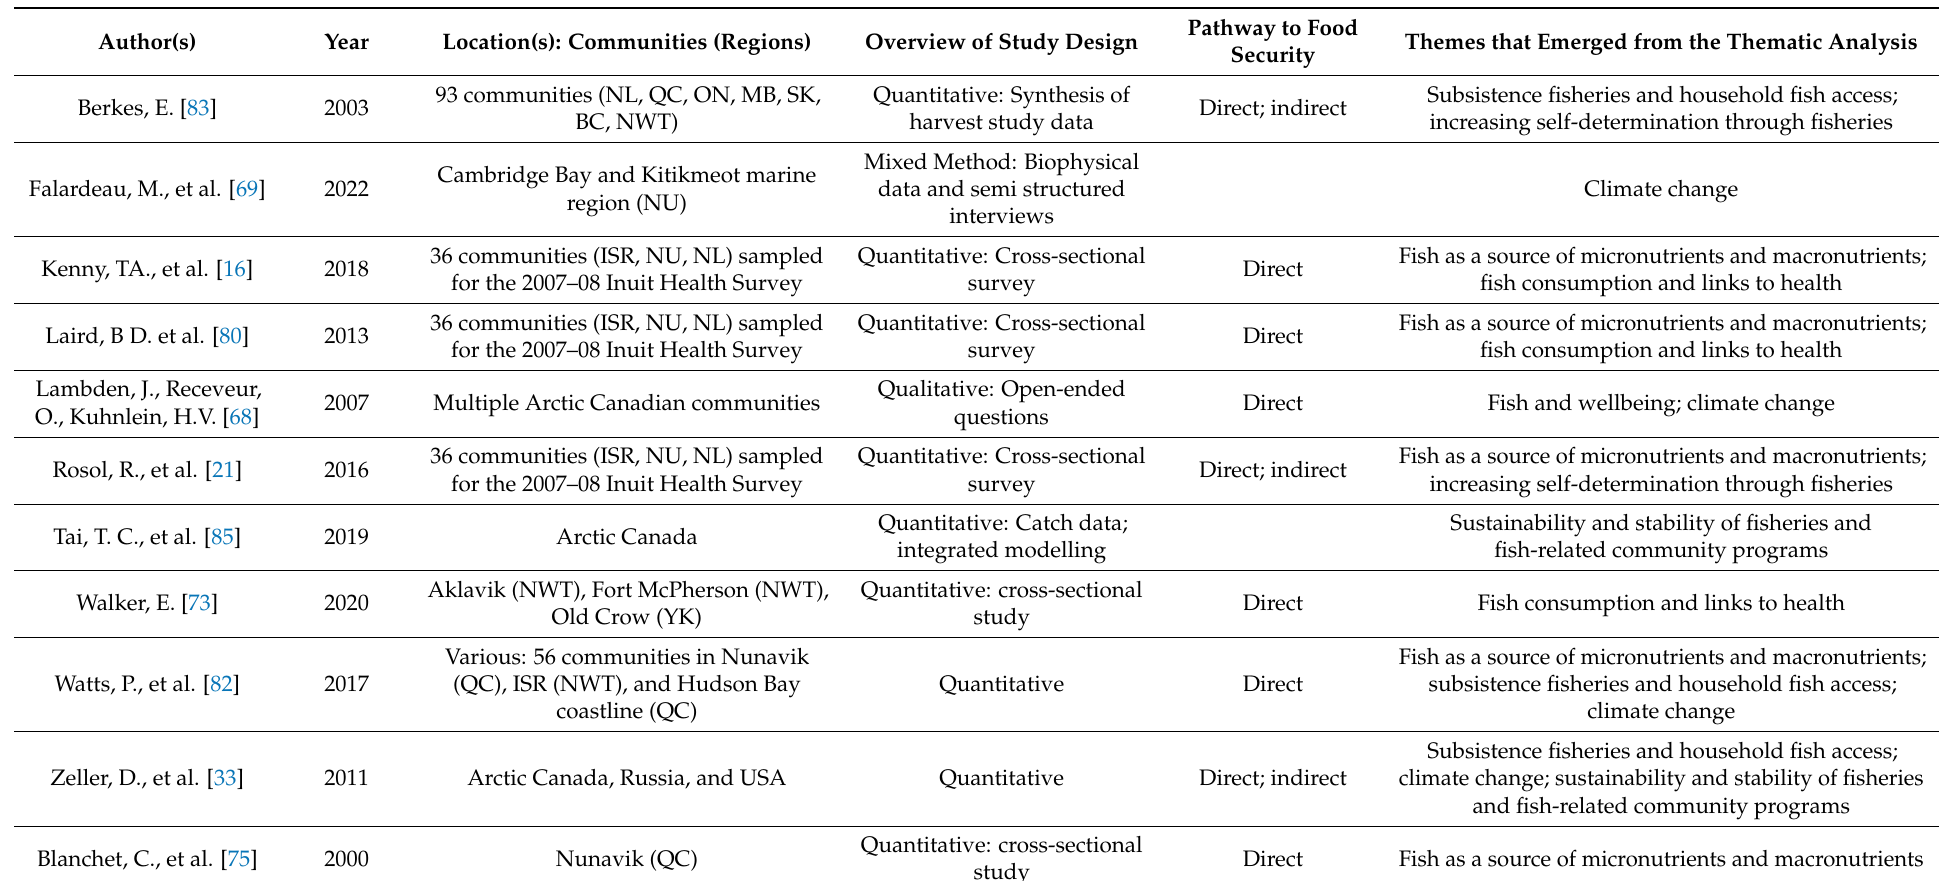
Table 2. Characteristics, pathways, and themes identified in the thematic analysis of the 31 articles included in this review examining the role of the fish, seafood, and fisheries in food security in Inuit Nunangat. Articles were ordered by region (Nunavik, Nunavut, ISR, and Nunatsiavut, or multiple regions in Inuit Nunangat for studies covering more than one